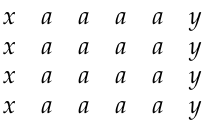
Figure 5. A picture array generated by Π 4